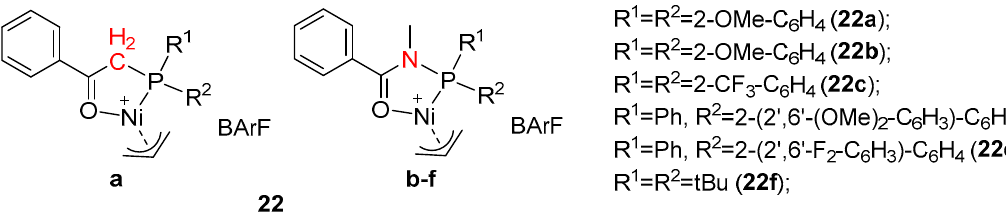
Figure 19. Cationic N -bridged phosphine–carbonyl Ni(II) catalysts 22a – f bearing various electronic nature and steric bulk.